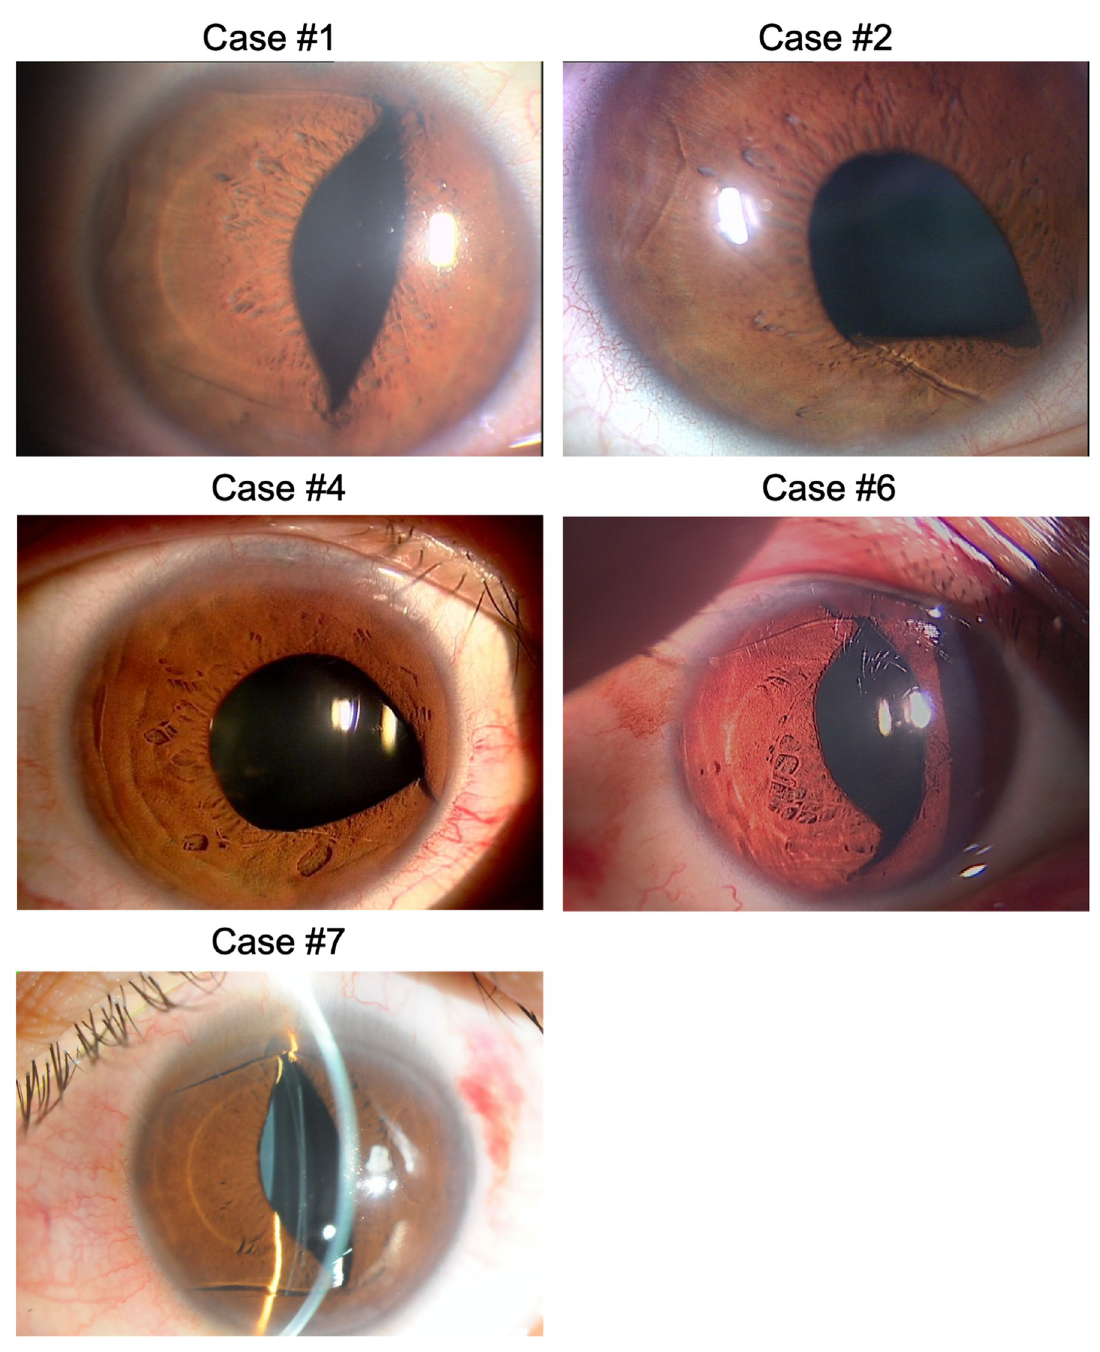
Fig 1. Representative slit-lamp findings of five patients with implantable collamer lens (ICL) dislocation. Case #1, ICL dislocation caused by another player’s hand hitting the right eye during futsal match. The superotemporal and inferotemporal haptics have prolapsed into the anterior chamber. Case #2, ICL dislocation caused by a futsal ball hitting the right eye. This case is a recurrent ICL dislocation of case #1. Case #4, ICL dislocation was caused by a futsal ball hitting the right eye. The inferonasal haptic has prolapsed into the anterior chamber. Case #6, ICL dislocation caused by a mortuary tablet hitting the right eye while working at a temple. The inferotemporal and superotemporal haptics have prolapsed into the anterior chamber. Mild anterior chamber inflammation was noted at the first visit after ICL dislocation, and retinal detachment was found at 8 th day of ocular injury. Case #7, ICL dislocation caused by another player’s elbow hitting the right eye during basketball match. The inferotemporal and superotemporal haptics have prolapsed into the anterior